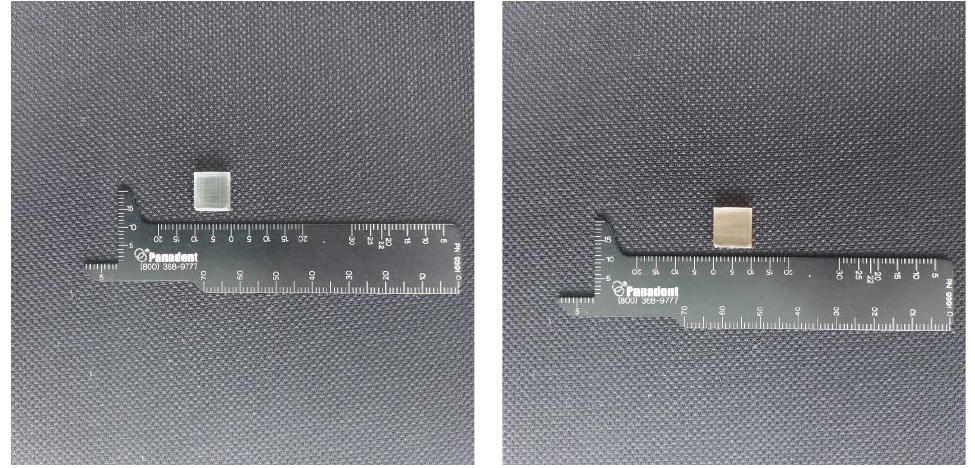
Figure 1. The shape of the samples used for the compression test, size of the sample: 10 ± 0.2 mm × 10 ± 0.2 mm × 4 ± 0.2 mm ( left —Dental Clear LT, right —BioMed Amber).